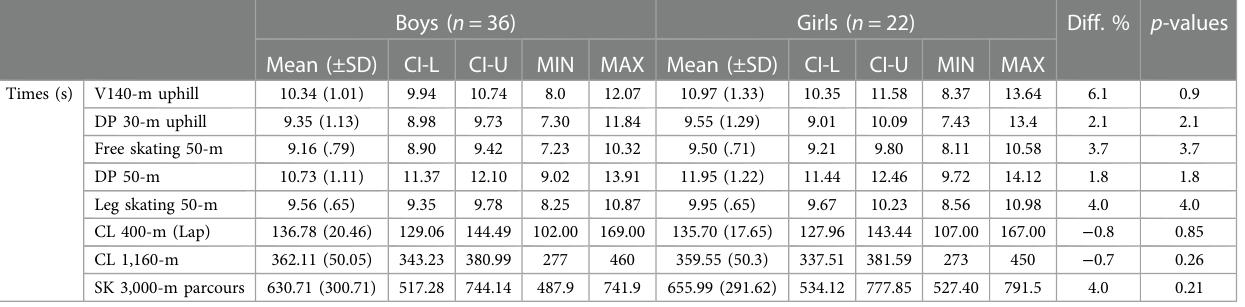
TABLE 3 Sex comparison in XC skiing performance.